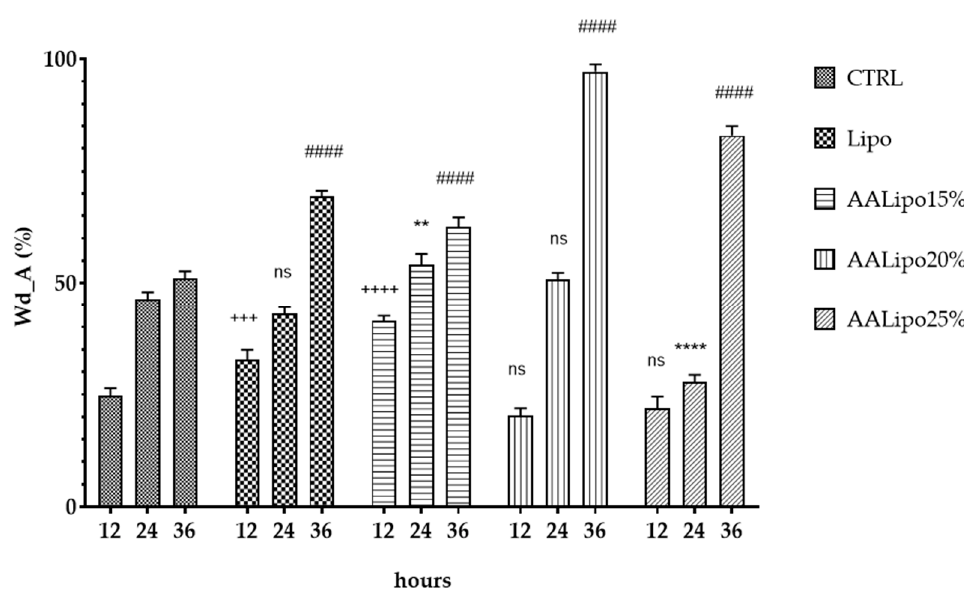
Figure 7. Quantitative measurements of “wound closure” at different time points (12, 24, and 36 h) with respect to each liposomal treatment. +++ ( p < 0.001); ++++ ( p < 0.0001)—significant difference compare to control at 12 h, ** ( p < 0.01); **** ( p < 0.0001)—significant difference compared to control at 24 h; #### ( p < 0.0001)—significant difference compare to control at 36 h; ns—no significant dif- ference.